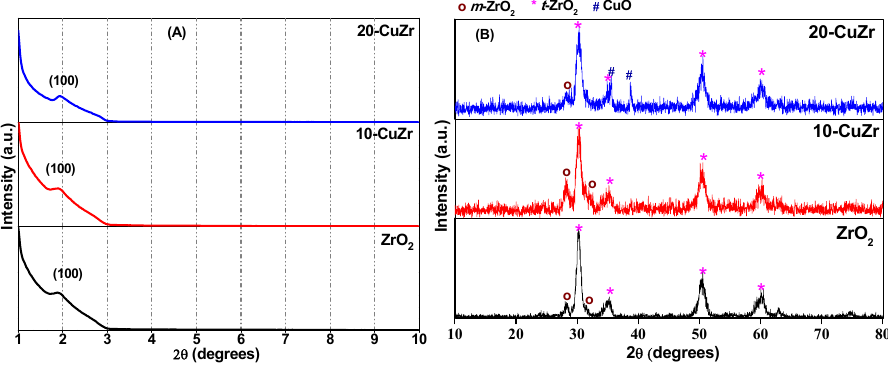
Figure 1. ( A ) Low angle X ‐ ray diffraction (XRD) ( B ) High angle XRD patterns of the samples. Table 1. Results from XRD and H 2 ‐ Temperature programmed reduction (H 2 ‐ TPR)